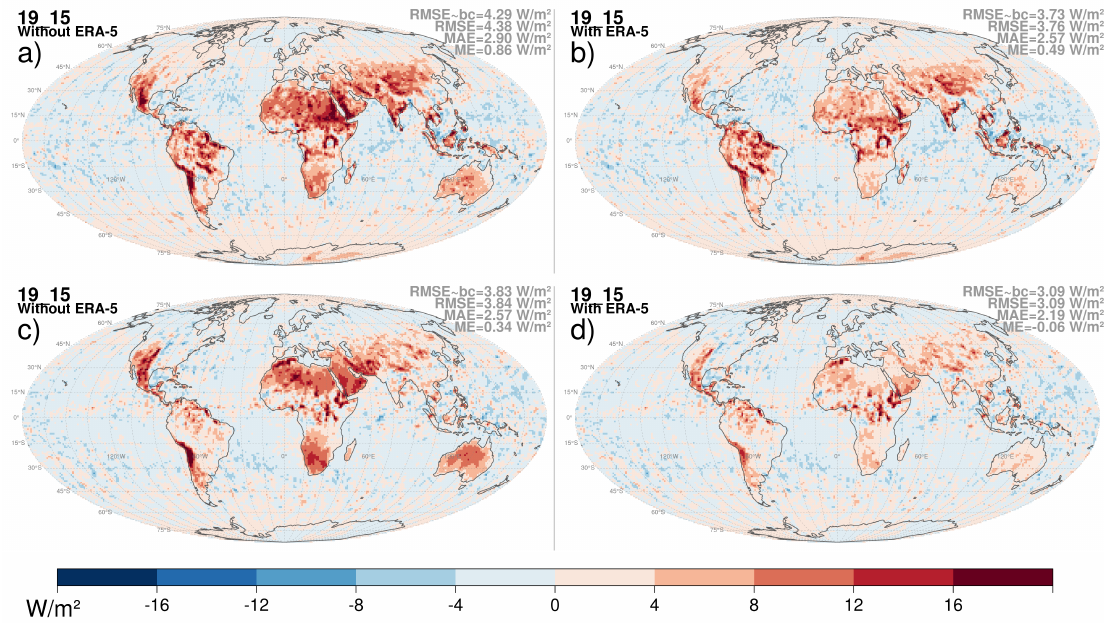
Figure 7. Difference between the monthly mean OLR calculated by only using NOAA-19 and by only using NOAA-15, for April ( a , b ) and June ( c , d ) 2012, with ( a , c ) linear temporal interpolation and ( b , d ) ERA5 diurnal cycle modeling for clear land